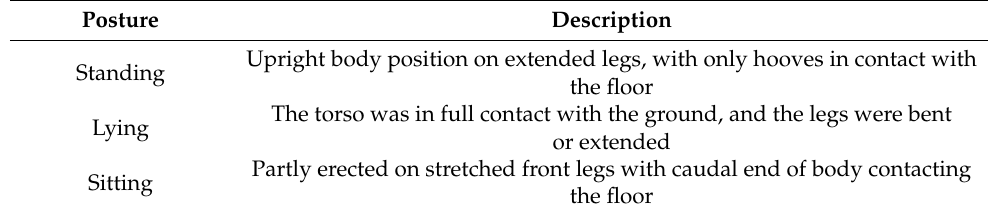
Table 1. Definition and description of pig postures.